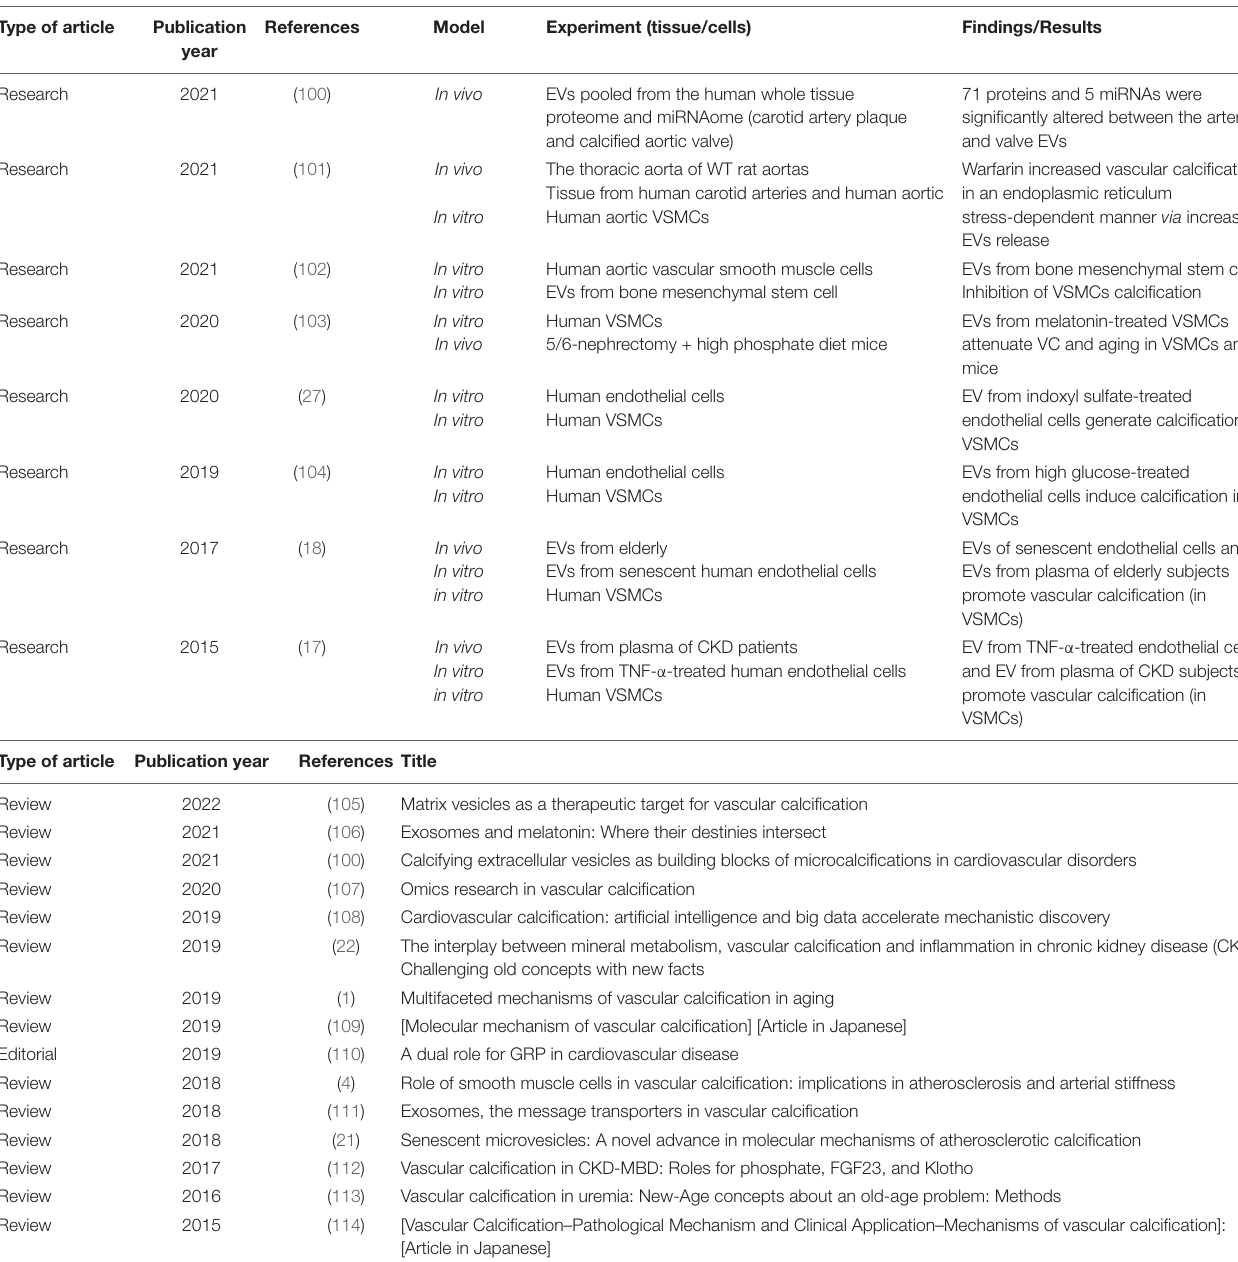
TABLE 1 | Original research articles and reviews obtained after a search in PubMed with the following keywords: “extracellular vesicles” and “vascular calcification” and